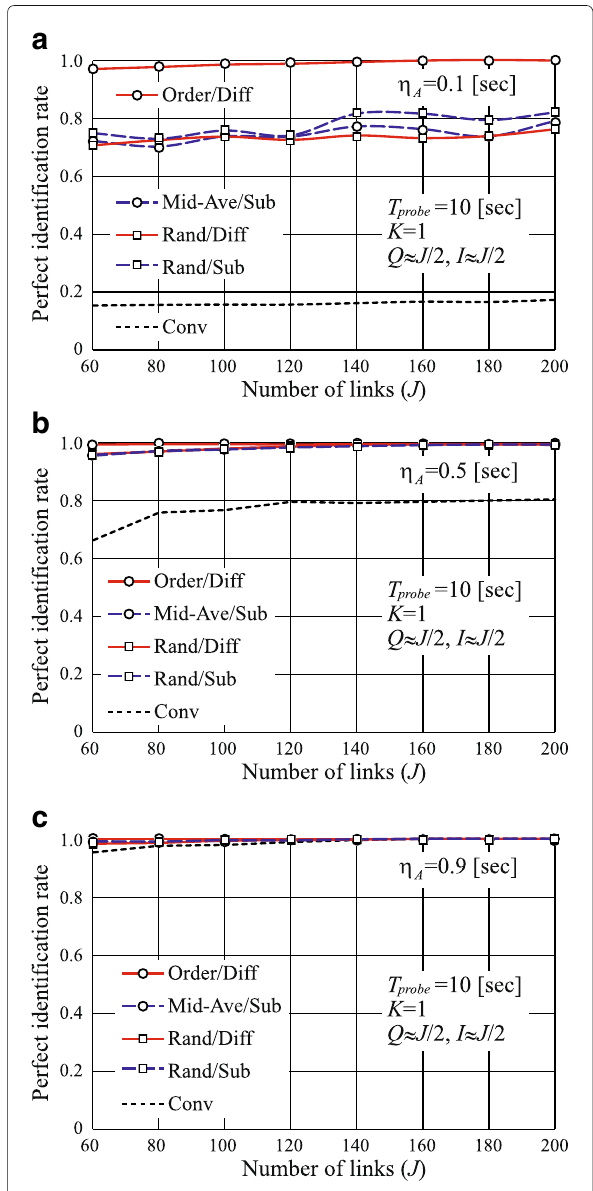
Fig. 9 Dependency on the network size. a η A = 0.1, b η A = 0.5, and c η A = 0.9